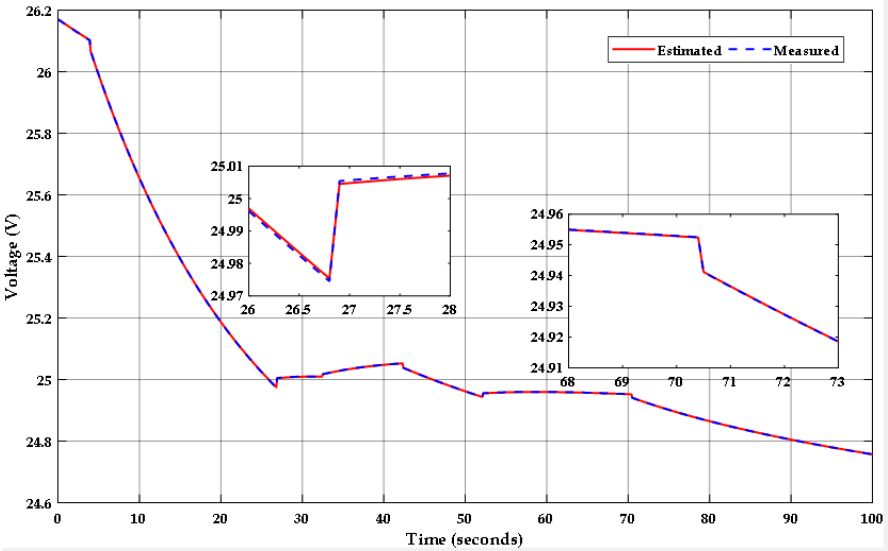
Figure 7. Voltage curves of the battery model and the measured data.